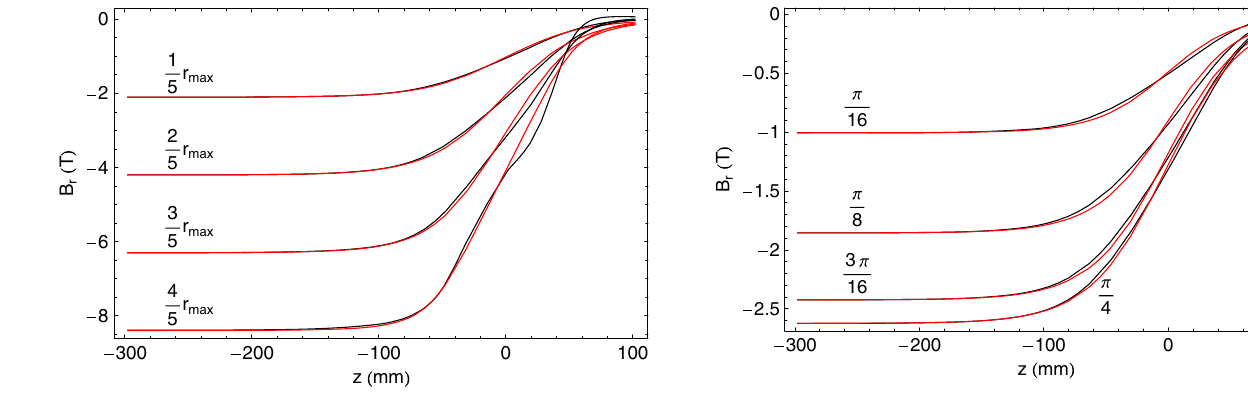
FIG. 8. Radial component of the magnetic field in an HL-LHC FIG. 7. Radial component of the magnetic field in an HL-LHC inner triplet quadrupole as a function of position along lines of inner triplet quadrupole as a function of position along lines of = 4 . Each pair of black and red lines shows fixed distance r ¼ r given radius and with cylindrical polar coordinate θ ¼ π = 4 . Each max the field at a different value of the cylindrical polar coordinate θ , pair of black and red lines shows the field at a different radius, from π = 16 to π = 4 (in steps of π = 16 ). The black lines show the 75 mm. The black lines = 5 to 4 r = 5 , with r from r max max max ¼ field obtained from the (numerical) magnetic model; the red lines show the field obtained from the (numerical) magnetic model; show a symmetrized form of the analytical model (49) – (51), with the red lines show a symmetrized form of the analytical model = 10 , and fit parameters given in Table I with radius of fit r (49) – (51), with fit parameters given in Table I with radius of fit max b 2 ¼ 2 . 5 . r = 10 , and b 2 ¼ 2 . 5 . max Fig. 10, which show the radial field component as a function of position along lines with fixed polar coordinate θ ¼ π = 4 and different distance r from the axis of the magnet. The plot on the left in Fig. 10 shows a comparison between the numerical field map and the analytical model with b 2 ¼ 1 . 5 ; the plot on the right compares the numerical field map and the analytical model with b 2 ¼ 3 . 5 . In regions close to the axis of the magnet, changes in the value of b 2 in the range 1.5 to 3.5 have little effect on the